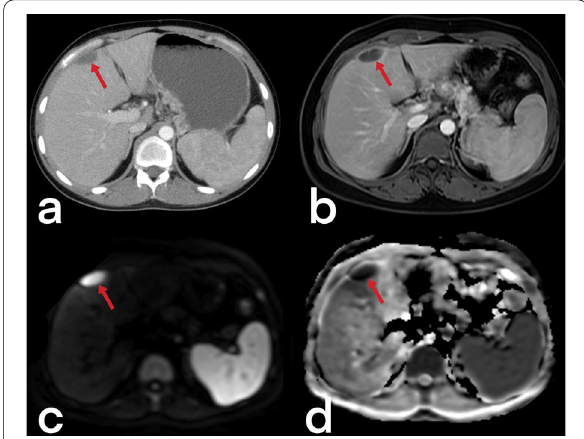
Fig. 30 Abdominal CT scan and MR images of the same patient (in Fig. 27). Contrast-enhanced CT ( a ) and T1 weighted contrast-enhanced MR images ( b ) show a small abscess formation with rim-like enhancement in the anterior subcapsular region of the liver. Diffusion-weighted images (DWI) ( c ) and apparent diffusion coefficient (ADC) map ( d ) reveal diffusion restriction consistent with an abscess